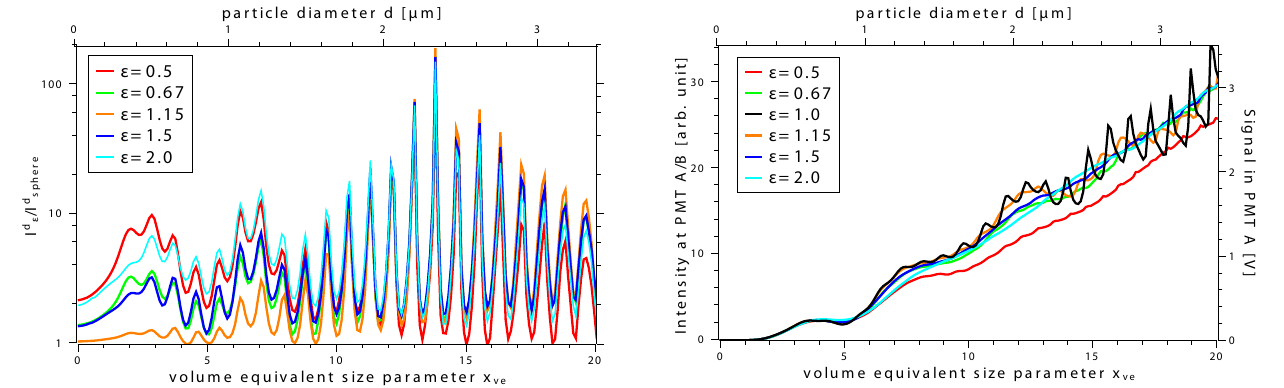
versus volume- A/B